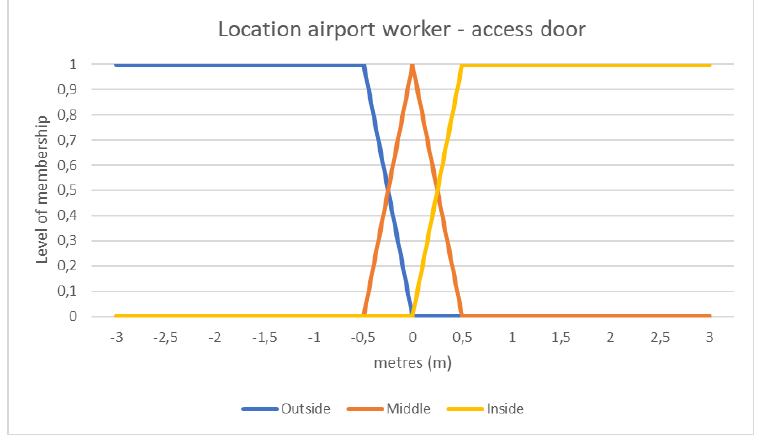
Figure 4. Fuzzy Sets Location Airport